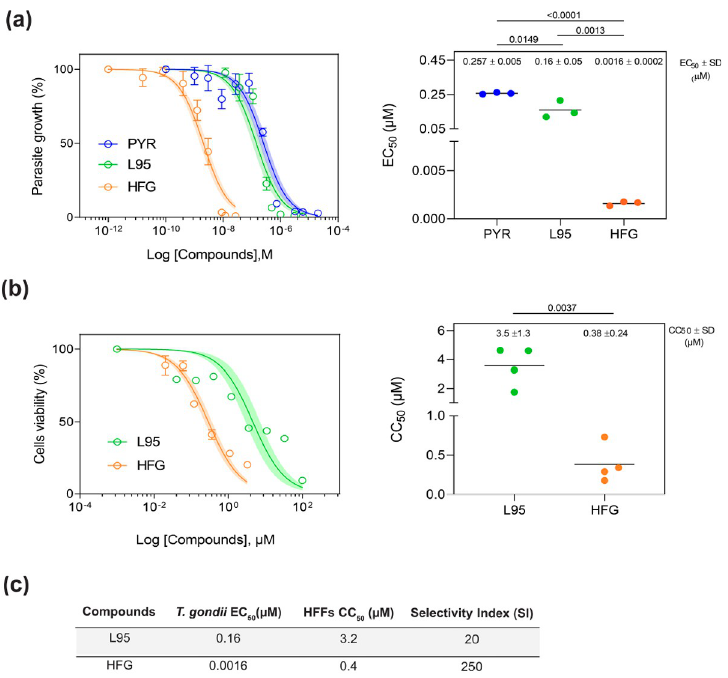
Fig 4. Cell-based inhibition profiles of HFG and L95 against parasite and host cells. (a) Graphs showing the dose- response curves (left panel) and the EC 50 values (right panel) for inhibition of T . gondii growth ex vivo in response to increasing concentration of pyrimethamine, L95 or HFG. Confluent HFF monolayer was infected with tachyzoites of T . gondii RH strain expressing the NanoLuc luciferase (RH NLuc). EC 50 values of each biological replicate were determined by non-linear regression analysis. EC 50 data are presented as mean ± SD from at least 2 independent biological replicates, each with 3 technical replicates. (b) Effect of L95 and HFG on host-cell viability. Dose-response curves (left panel) and CC 50 values (right panel) of HFFs in presence of L95 or HFG compounds are shown. HFF cells were incubated for 72 h in the presence of increasing concentrations of the indicated compounds. Cell viability was revealed using the CellTiter-Blue assay kit (Promega) and the CC 50 was determined by non-linear regression analysis. Dose-response graphs represent the mean ± SD of 3 technical replicates from one experiment. Shaded error envelopes depict 95% confidence intervals. EC 50 and CC 50 values are the mean ± SD from 4 independent biological replicates, each with 3 technical replicates. Statistical analyses were performed using one-way ANOVA test. (c) SI values were calculated by dividing the human cells CC 50 with the T . gondii EC 50 .